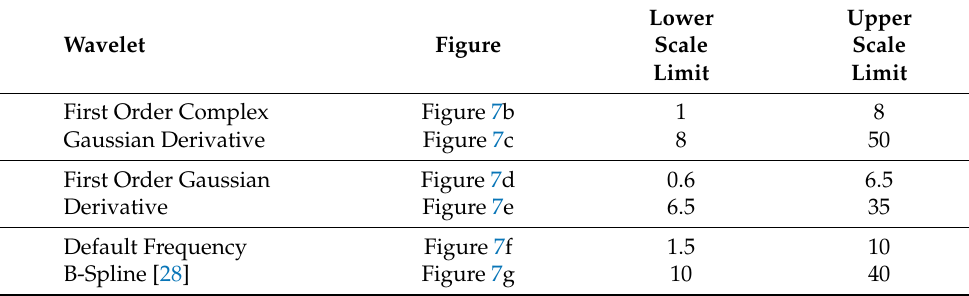
Table 1. Continuous wavelet transformation